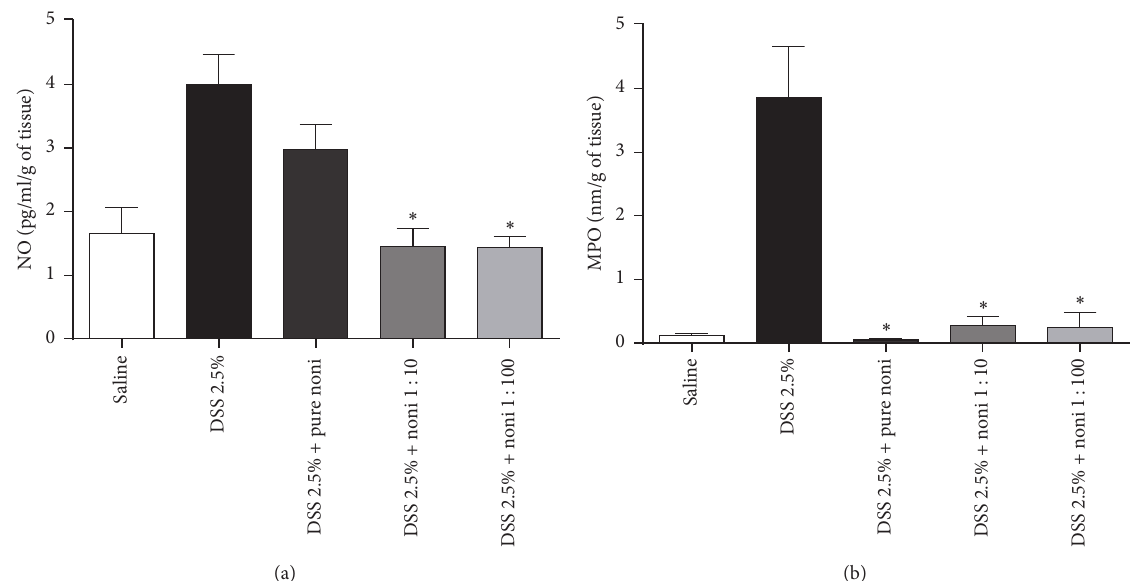
Figure 3: Noni fruit juice consumption inhibits inflammation by reducing nitric oxide and myeloperoxidase activities. C57BL/6 mice were exposed to dextran sulfate sodium (DSS) 2.5% and treated daily with noni fruit juice. On day 9, the mice were euthanized in order to obtain intestinal sections. Quantification of intestinal production of nitric oxide (a) and myeloperoxidase (MPO) activity, expressed as picogram per milliliter per gram of tissue (pg/ml/g) and as optic density per gram of tissue (nm/g of tissue), respectively. Data are represented as mean ± SEM. ∗ 𝑝 < 0.05